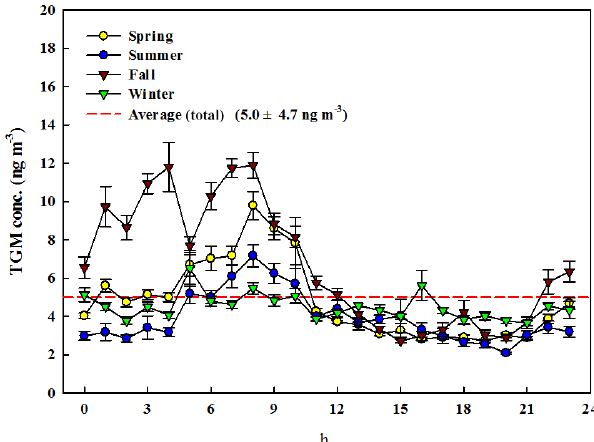
Figure 3. The diurnal variations of TGM concentrations during the sampling periods. The error bars represent standard